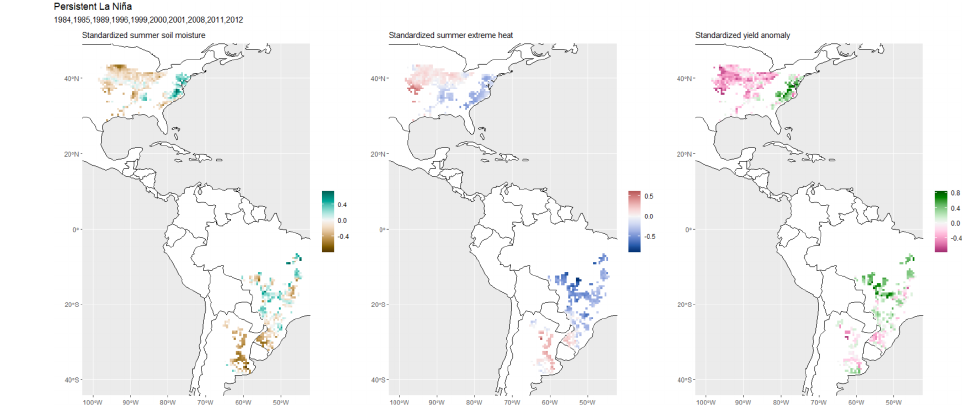
Figure A5. Composites of summer soil moisture, summer extreme heat and soybean yield anomalies for persistent La Niña years (indicated in the subtitle). Summer periods are JFM in the Southern Hemisphere and JAS in the Northern Hemisphere. Persistent La Niña years are defined as events when both OND and AMJ ENSO indices are below − 0 . 5.